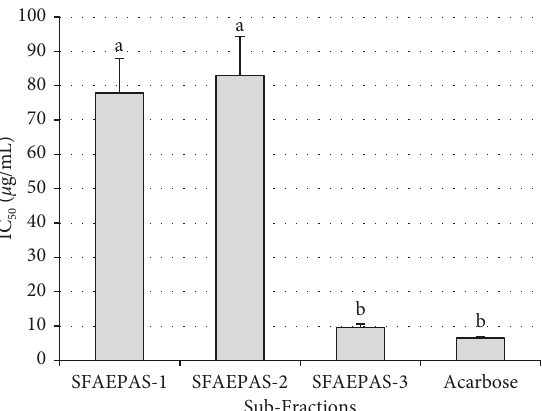
Figure 3: IC 50 of subfractions. NB: columns with different superscript alphabets are significantly (